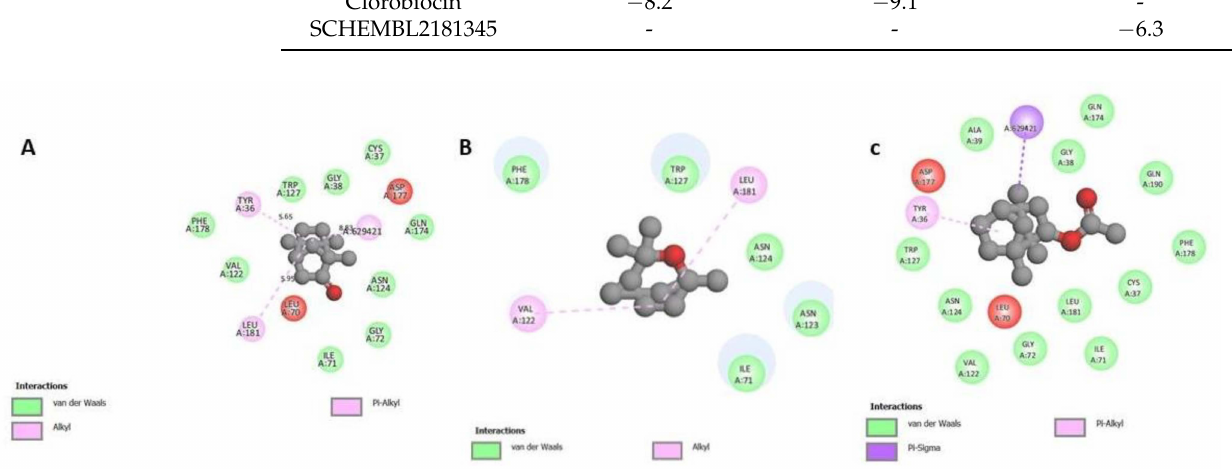
Figure 3. 2D scheme of TyrRS interaction with the tested ligands ( A ) Eucalyptol; ( B ) Camphor; ( C ) Bornyl